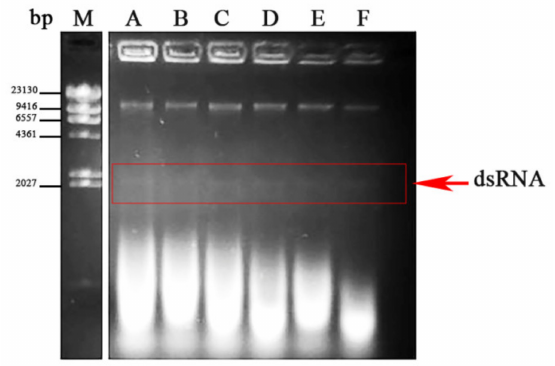
Figure 1. dsRNA-enriched extracts from di ff erent isolates of Fusarium oxysporum f. sp. dianthi . Agarose gel electrophoresis of the dsRNA extracts obtained by cellulose column chromatography from di ff erent isolates (A-F) of F. oxysporum f. sp. dianthi. M: molecular weight marker II (Roche Diagnostics, Rotkreuz,